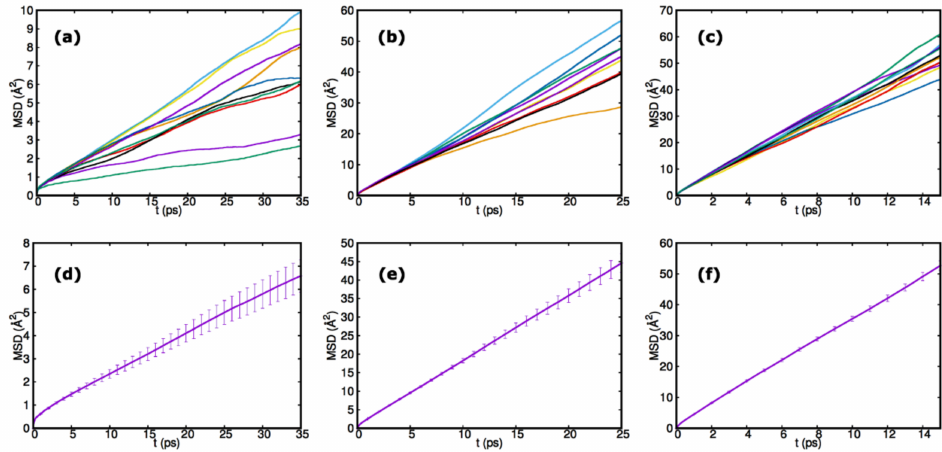
Figure 3. Lithium-ions mean square displacement (MSD) with time. Results for ten iterative compu- tations of Li 5 PS 4 Cl 2 at ( a ) 300 K, ( b ) 600 K, ( c ) 800 K, and MSD of the ions with respect to time with the error bars for ten iterative simulations considering ( d ) 300 K, ( e ) 600 K, ( f ) 800 K. Adapted from Baktash et al. [19].